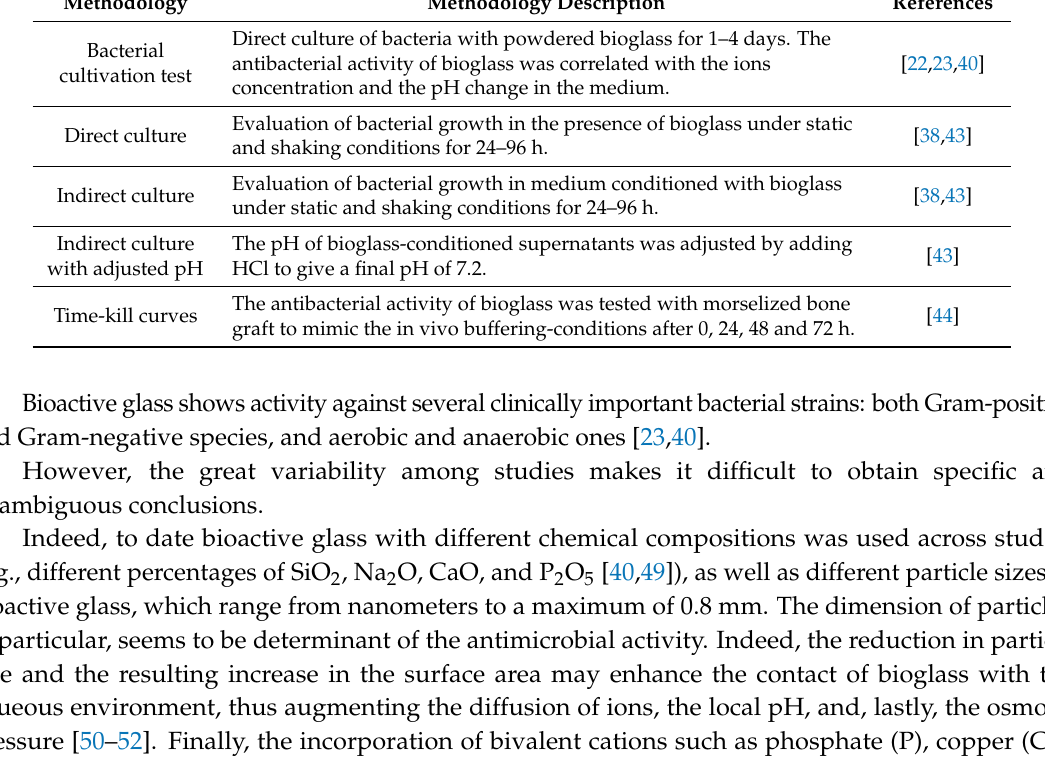
Table 2. The main methods to assess the antibacterial activity of different types of bioactive glass.